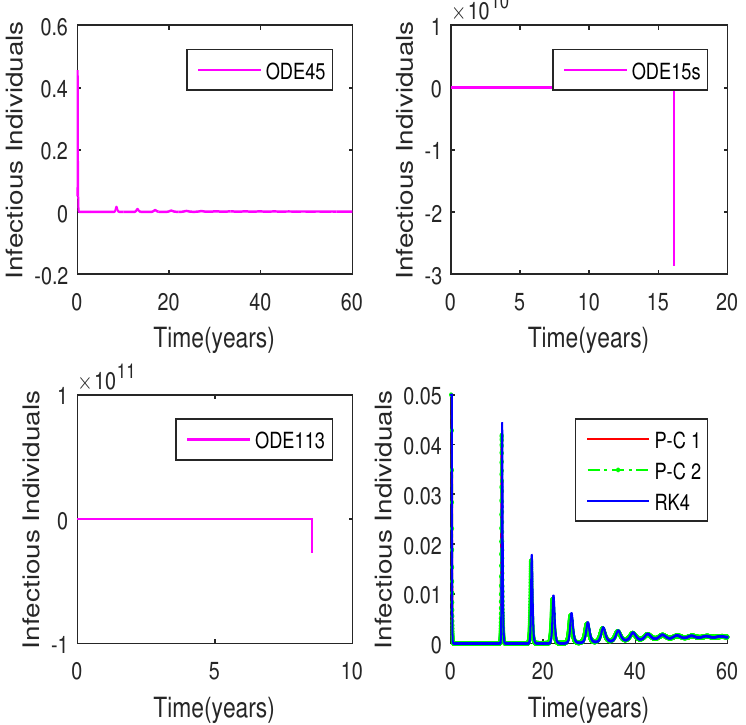
Figure 1. The numerical results of system (2) using P-C schemes with h = 0.01, ode45 and RK4 scheme with h = 0.005 taking parameter values ( R 0 > 1 ) and I.C. S 0 = 0.9, I 0 = 0.05, ν = 24, µ = 0.04, β = 123, R 0 = 0.05.